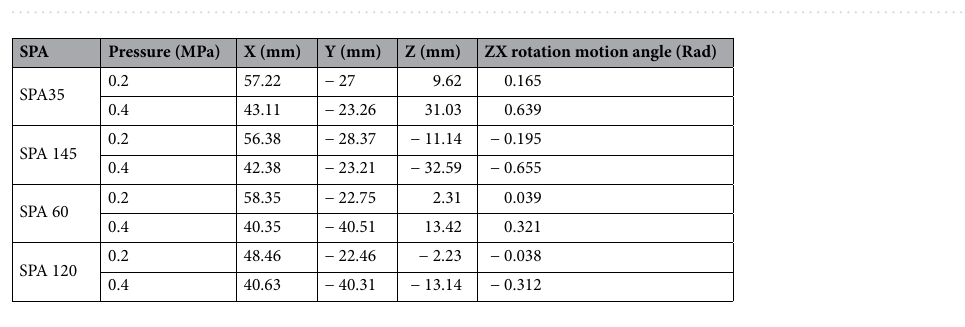
Table 1. Comparing XYZ coordinates and Z/X rotation motion angle for front and back SPAs at 0.2 and 0.4